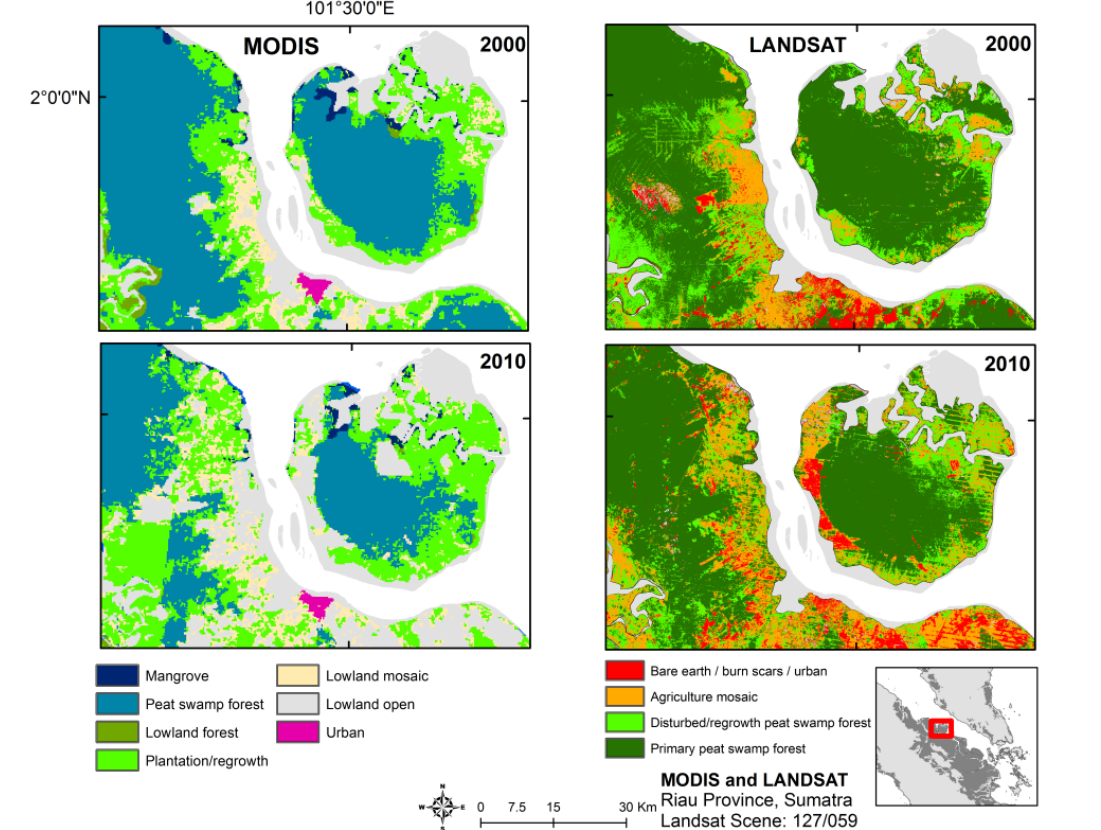
Figure 9. Comparison of the 2000 and 2010 Landsat mosaics with the corresponding MODIS mosaics of 2000 and 2010 created by Miettinen et al. [11], Northern Riau Province, Sumatra,